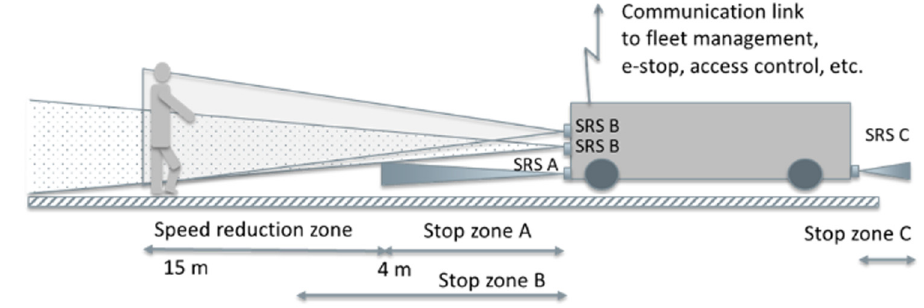
Figure 4: An example of autonomous mobile machine and its on - board perception sensors and their detection